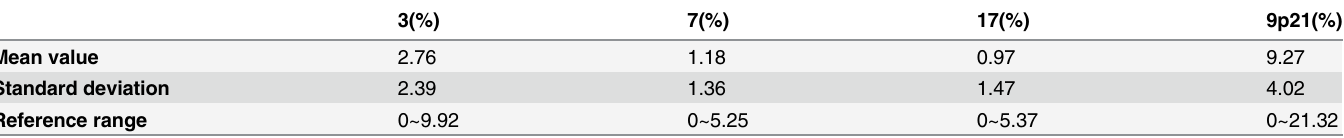
Table 4. The normal values of chromosomes 3, 7 and 17 or of 9p21.